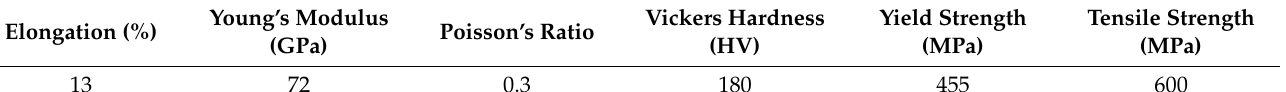
Table 1. Properties of 7075 aluminum alloy at room temperature.